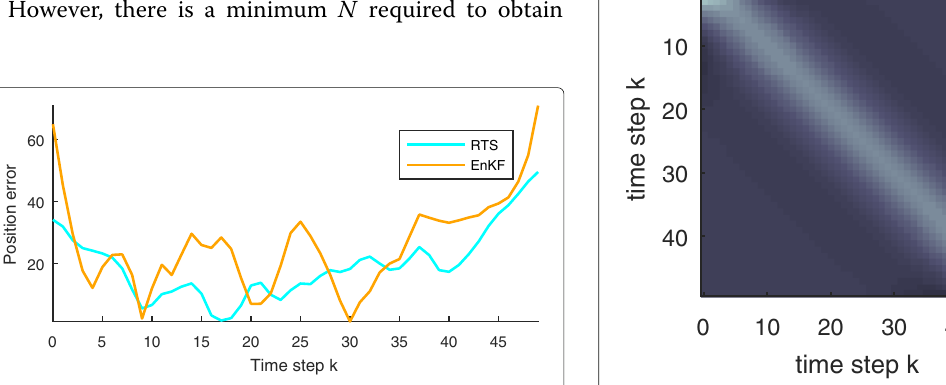
Fig. 10 Position errors of the RTS ( cyan ) and the EnKF ( N = 50, orange ) after updating with all measurements in the order y 1 , ... y L